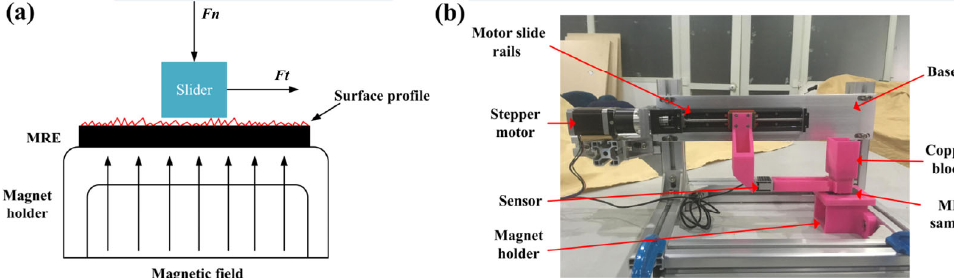
Fig. 14 The schematic and the real photo of the friction test platform: (a) the schematic and (b) the real photo.